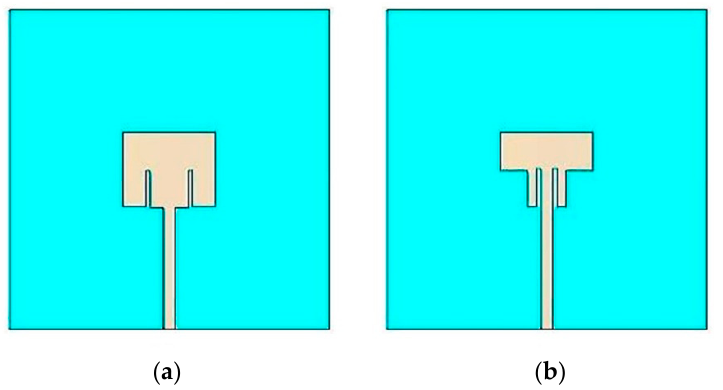
Figure 4. Sub-patches extracted from MPA2 configuration: ( a ) Low-frequency sub-patch (LFSP), ( b ) High-frequency sub-patch (HFSP).